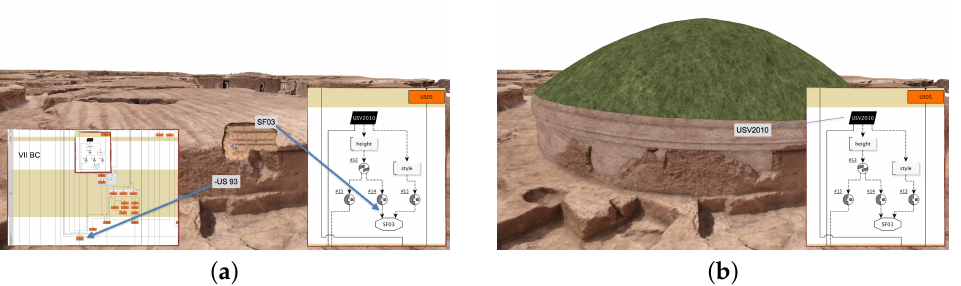
Figure 6. Reconstruction process of the mound 2488 of the Onde Marine site. ( a ) Special Find (SF) relocated in its supposed original place. Below the EM with the negative stratigraphic unit related to the destruction. ( b ) USV 2010 related to the reconstruction hypothesis of the mound 2488. As in the detail of the EM on the right, some of the properties are based on the relocated SF03.